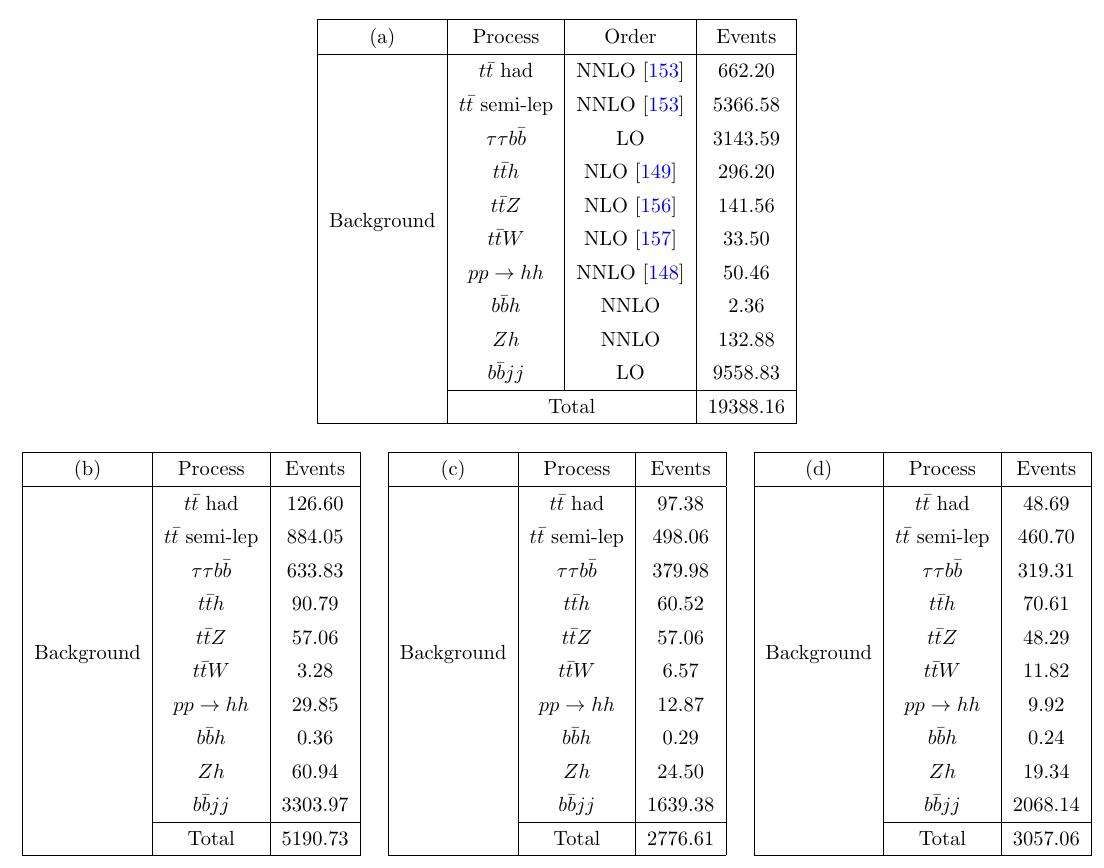
Table 10 . Background yields after the BDT analysis for heavy Higgs mass of ( a ) 400 GeV, ( b ) 600 GeV, ( c ) 800 GeV and ( d ) 1000 GeV for the b (cid:22) b(cid:28) h (cid:28) h channel. the transverse mass of all the visible products plus =E T . The rest of the variables have